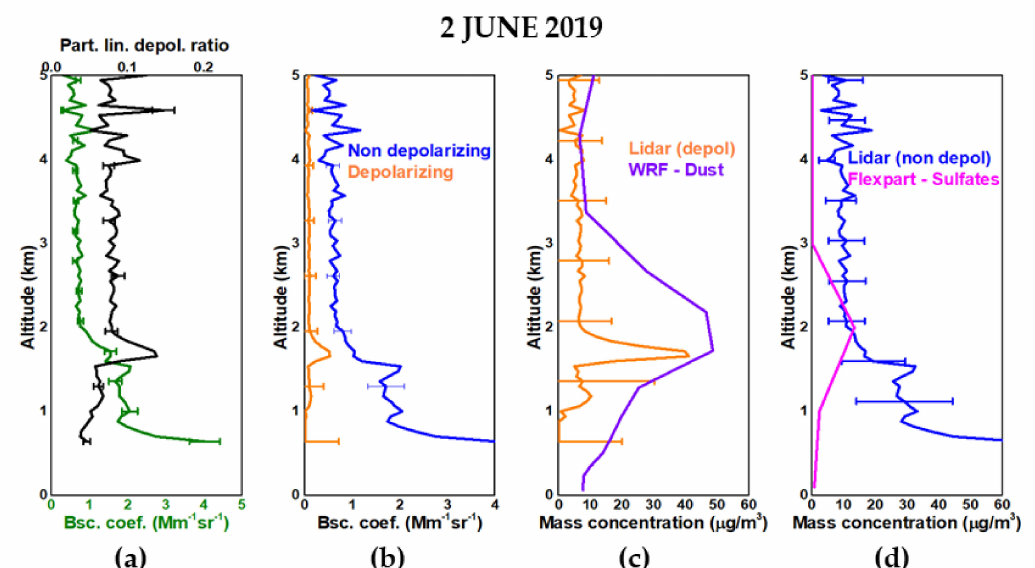
Figure 10. ( a ) Particle backscatter coefficient profiles (green line) and particle linear depolarization ratio (black line) at 532 nm, ( b ) non-depolarizing (sulfate/pollution) backscatter coefficient (blue line) and depolarizing (ash/dust) backscatter coefficient (orange line), ( c ) mass concentration profile of the depolarizing (Lidar depol—orange line) and WRF dust averaged concentration (purple line), and ( d ) mass concentration profile of the non-depolarizing (Lidar non-depol—blue line) component and sulfates averaged concentration (magenta line), at 17:00 to 18:00 UTC (in µ g/m 3 ) on 2 June